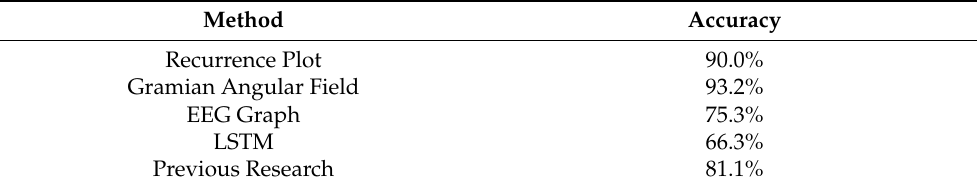
Table 3. Comparative analysis of learning results of EEG